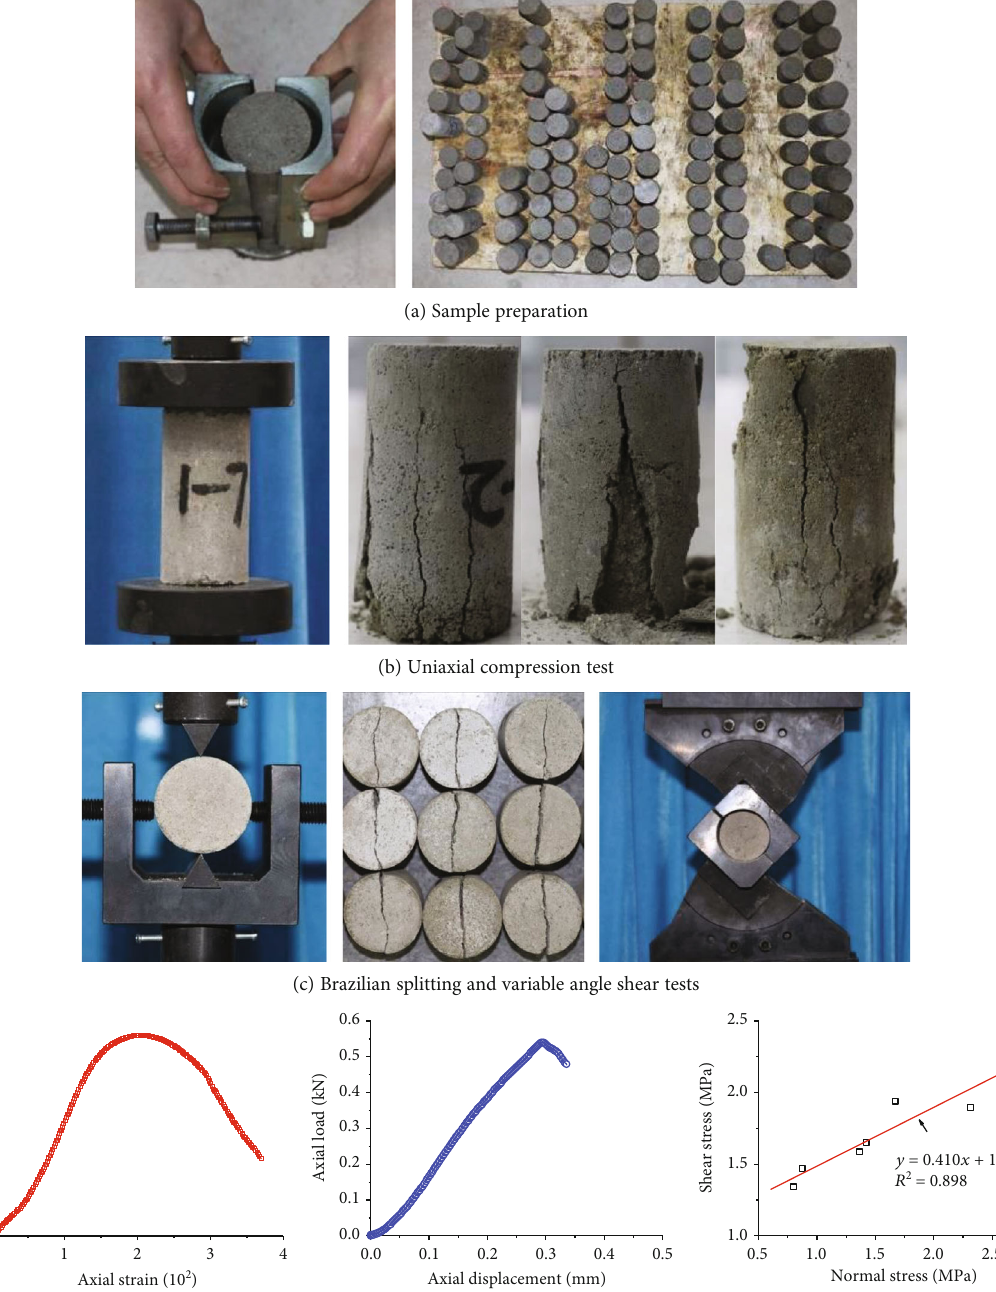
Figure 4: Experimental materials and basic mechanical